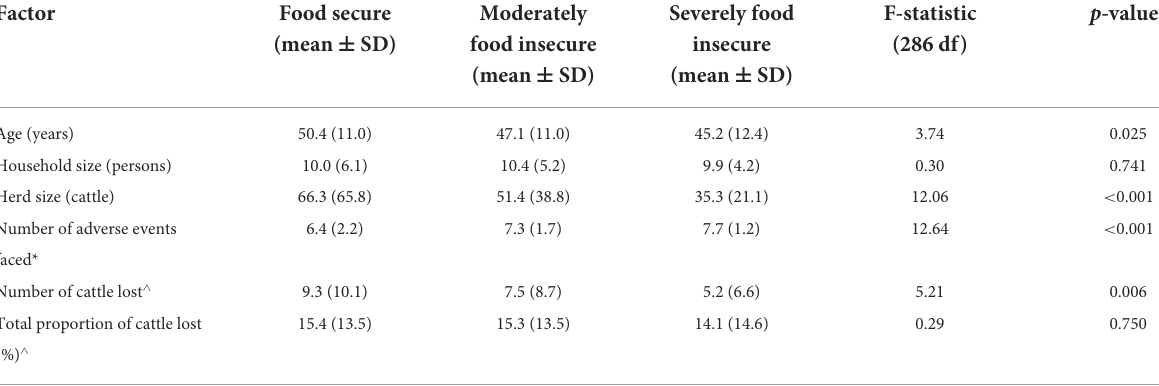
TABLE 3 Factors influencing the food security level of cattle farming households in Ghana (Part 2).